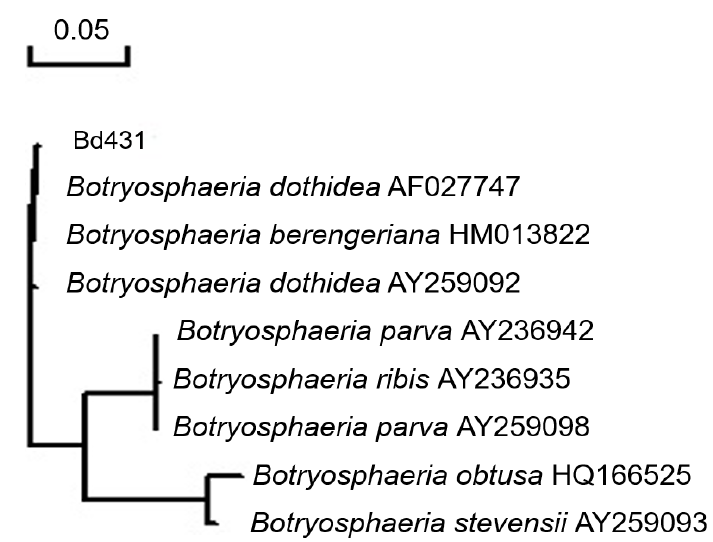
Figure 3. Dendrogram constructed by the neighbor-joining method showing the phylogenetic relationship (100%) between the isolate of Botryosphaeria dothidea (BD431) and B. dothidea isolate (AF027747) based on the We have checked (ITS) sequences.